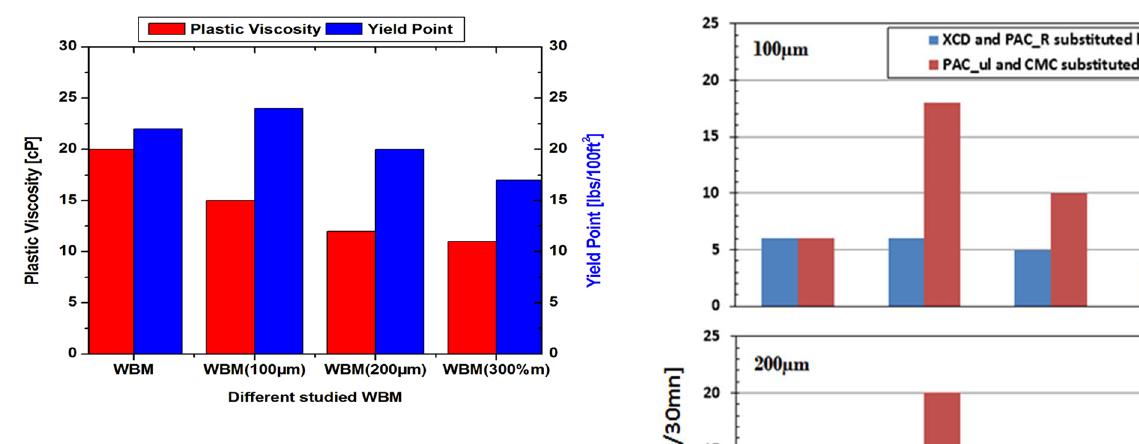
Fig. 9 Main rheological parameters of studied muds: XCD and